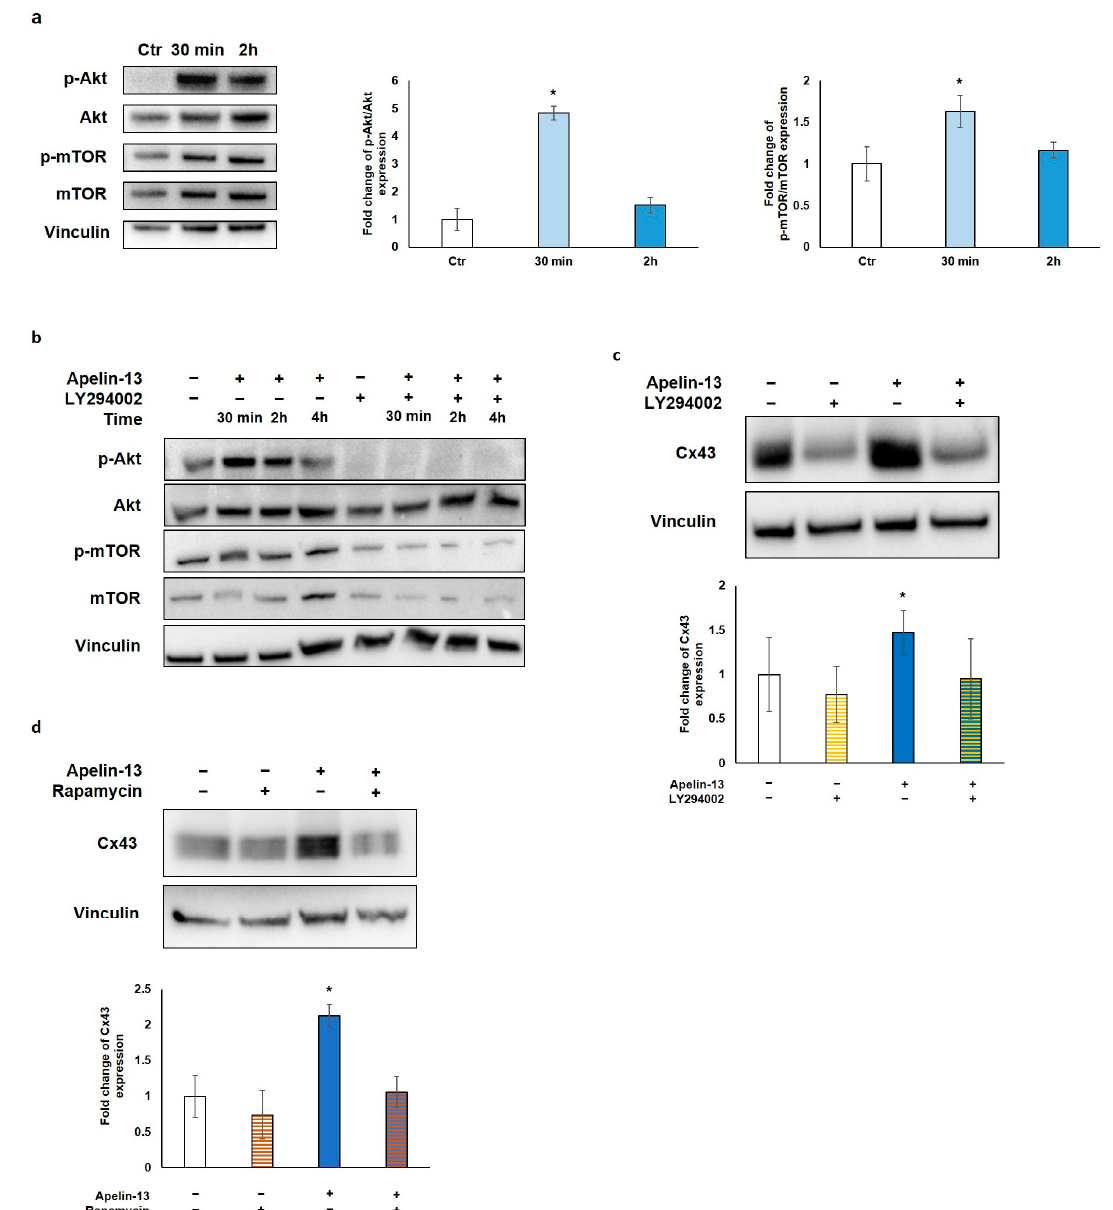
Figure 4. Apelin-13 increases Cx43 via Akt/mTOR-dependent autophagic pathway. ( a ) Western blot analysis of pathway activated in NMCs by 100 nM Apelin-13 treatment for 30 min and 2 h. Central graph shows quantification of p-Akt/Akt protein expression in Apelin-13-treated NMCs. Vinculin served as internal control (mean ± SEM; * p ≤ 0.05; n = 6). Graph on the right shows quantification of p-mTOR/mTOR protein expression in Apelin-13-treated NMCs (mean ± SEM; * p ≤ 0.05; n = 7). vs. Ctr cells. ( b ) Western blot evaluation of effect of 100 nM Apelin-13 for 30 min, 2 h, and 4 h alone